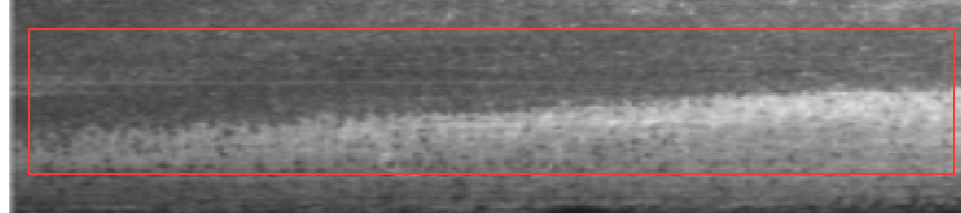
Figure 3. Negative example predicted as positive by Yolov5.